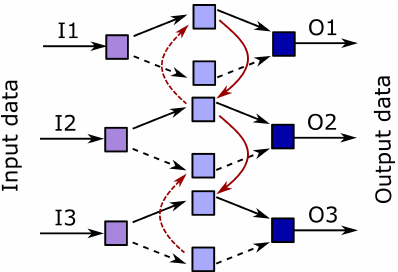
Figure 3. Scheme of the used BiRNN network.